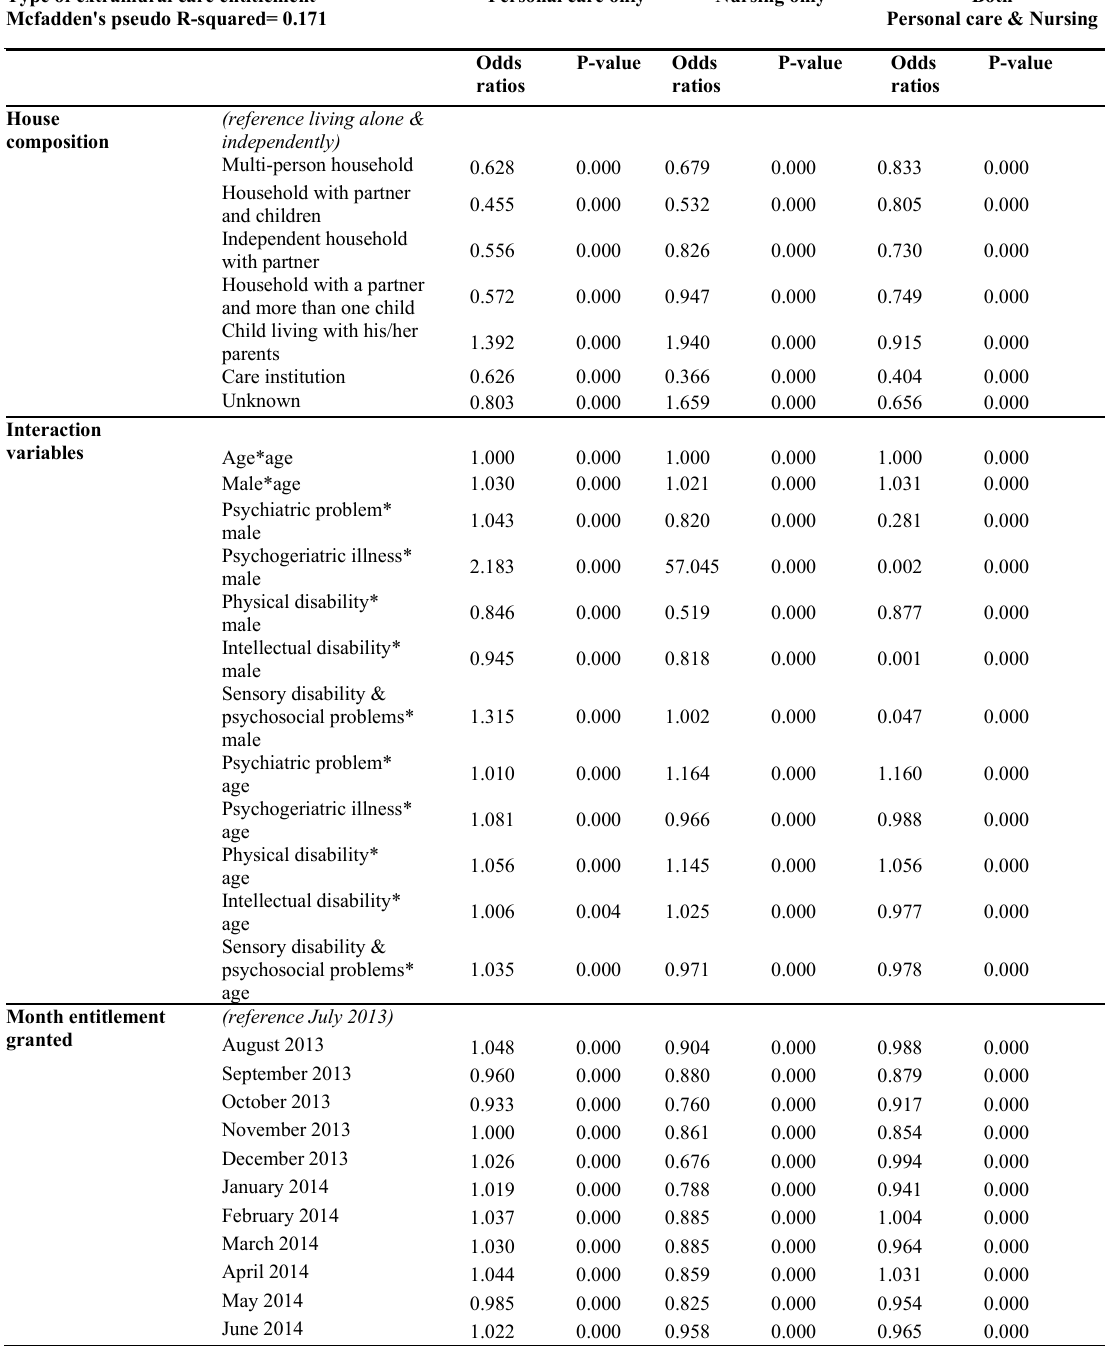
Table 3.1: Model 1 multinomial logistic model for the probability of an home care entitlement 65 and older